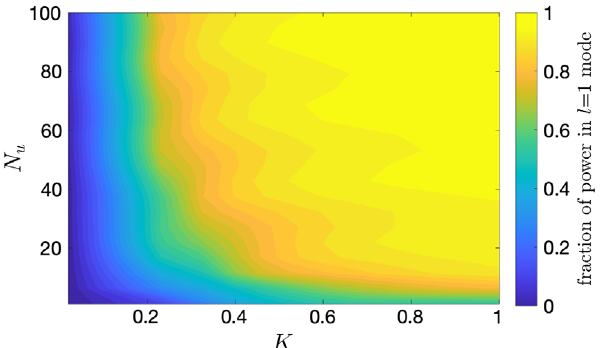
FIG. 3. Fraction of power in the l ¼ 1 mode (integrated over radial modes) emitted at the second harmonic in a RHU for a single electron with γ ¼ 7828 , λ ¼ 1 nm. It reaches 98% at ¼ 100 , and K ¼ 1 N u